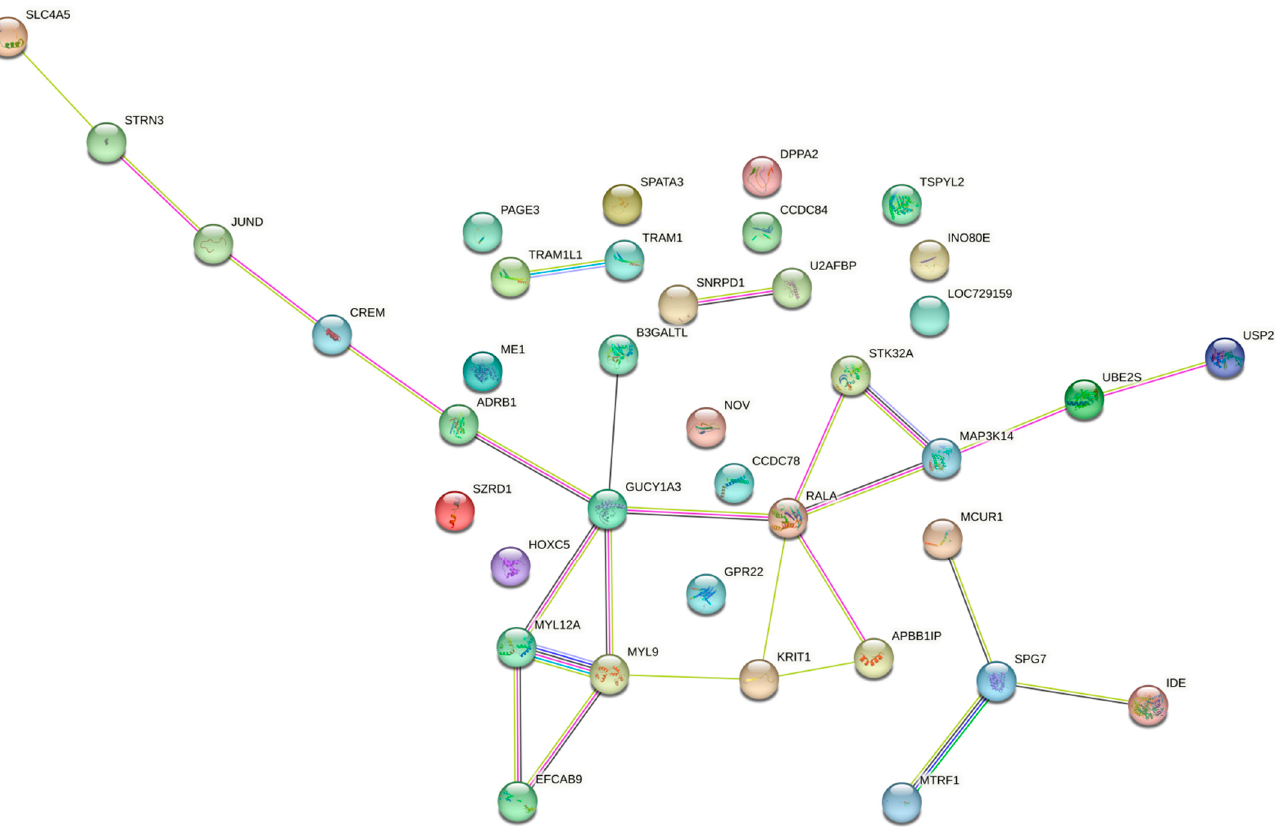
Figure 4. Protein–protein interaction network of 38 proteins that are universal to both BCPs and HFs blood-circulating NPCs. PPI networks plotted with STRING (http://string-db.org/, accessed on 1 1 March 2023) with following settings—minimum interaction score: high confidence (0.700); active interaction sources: textmining, experiments, databases, co-expression, neighborhood, gene fusion, co-occurrence.